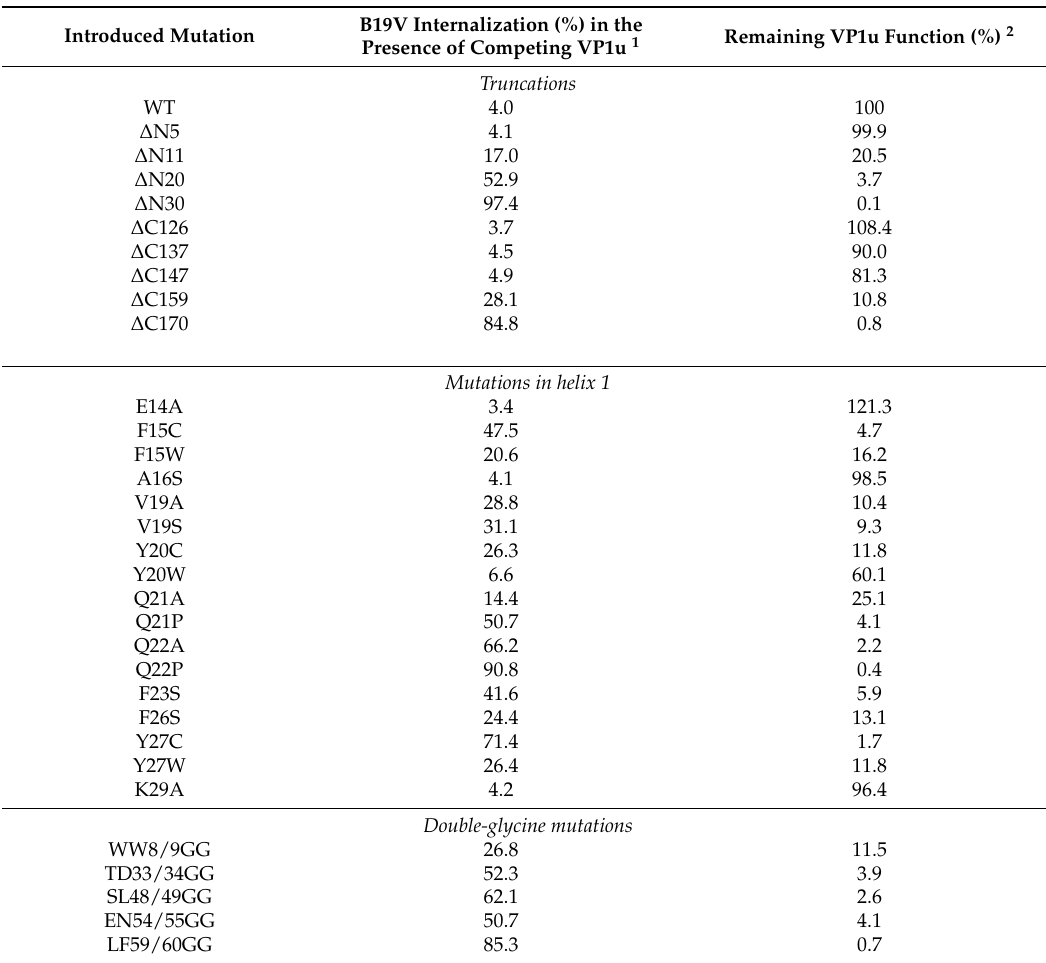
Table 1. Recombinant VP1u mutants generated by site-directed mutagenesis and their remaining internalization capacity on UT7/Epo